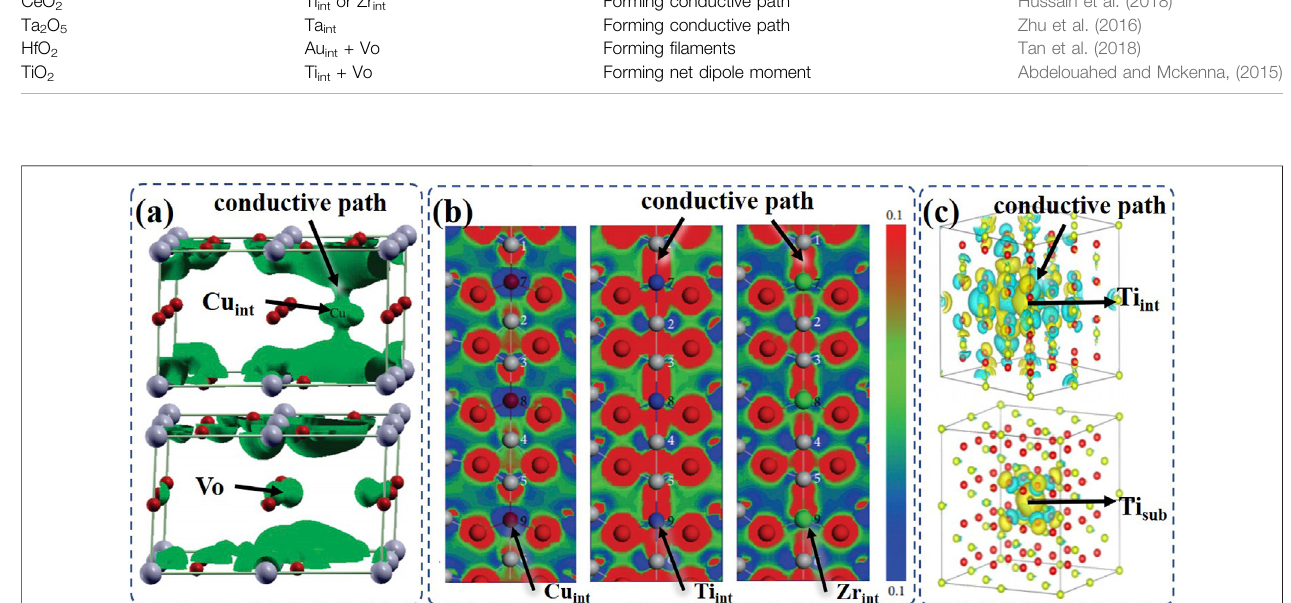
FIGURE 1 | (A) Isosurface plot of the partial charge density corresponding to the defect state induced by the interstitial Cu int and Vo in Ta 2 O 5 (reproduced with permission (Gu et al., 2010). Copyright 2010, American Chemical Society); (B) deformation electron density in [110] for the defected TiO 2 with the Cu int , Ti int, and Zr int (reproduced with permission (Li et al., 2015). Copyright 2015, Lei Li et al.); (C) isosurface plots of Ti int and Ti sub (reproduced with permission (Hussain et al., 2018). Copyright 2018, Springer-Verlag GmbH Germany).